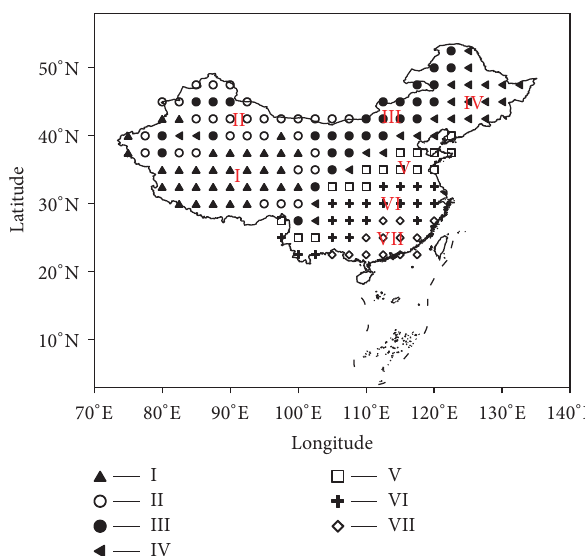
Figure 2: Grid-point classification results for